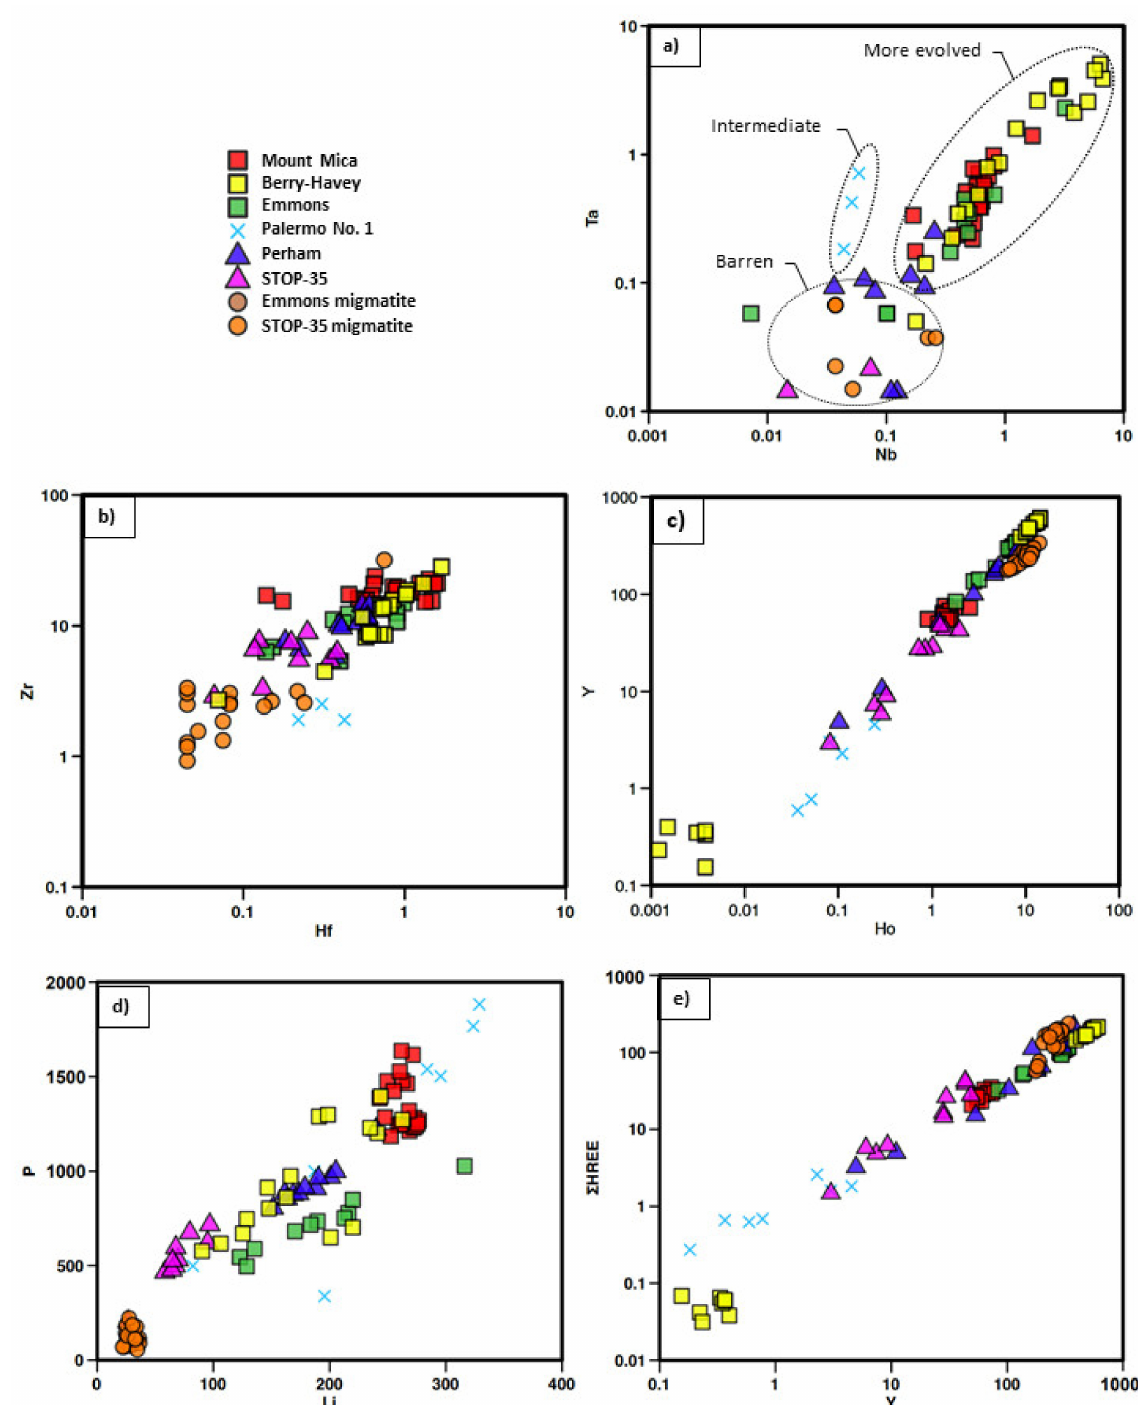
Figure 13. Trace elements binary plots for garnet samples analyzed by LA-ICP-MS (values in ppm). ( a ) Nb vs. Ta; ( b ) Hf vs. Zr; ( c ) Ho vs. Y; ( d ) Li vs. P; and, ( e ) Y vs. Σ